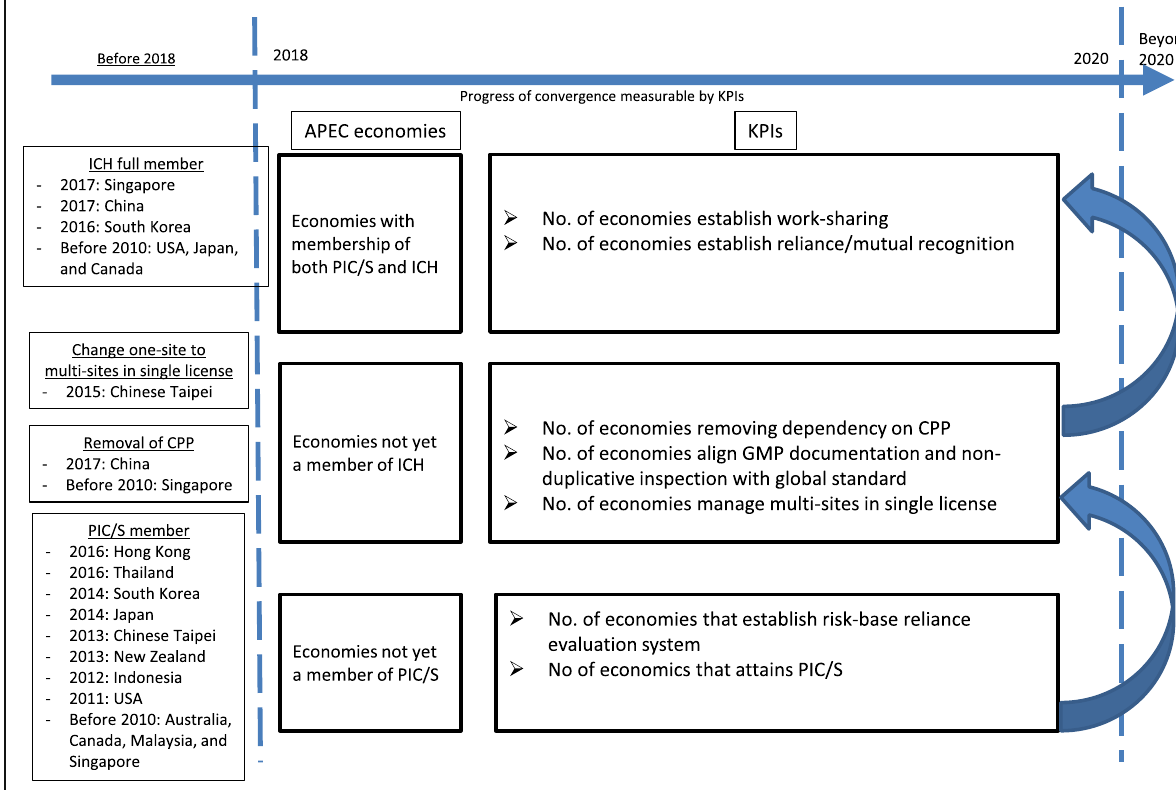
Fig. 2 Progress of convergence measurable by proposed KPIs before 2018 to 2020 and